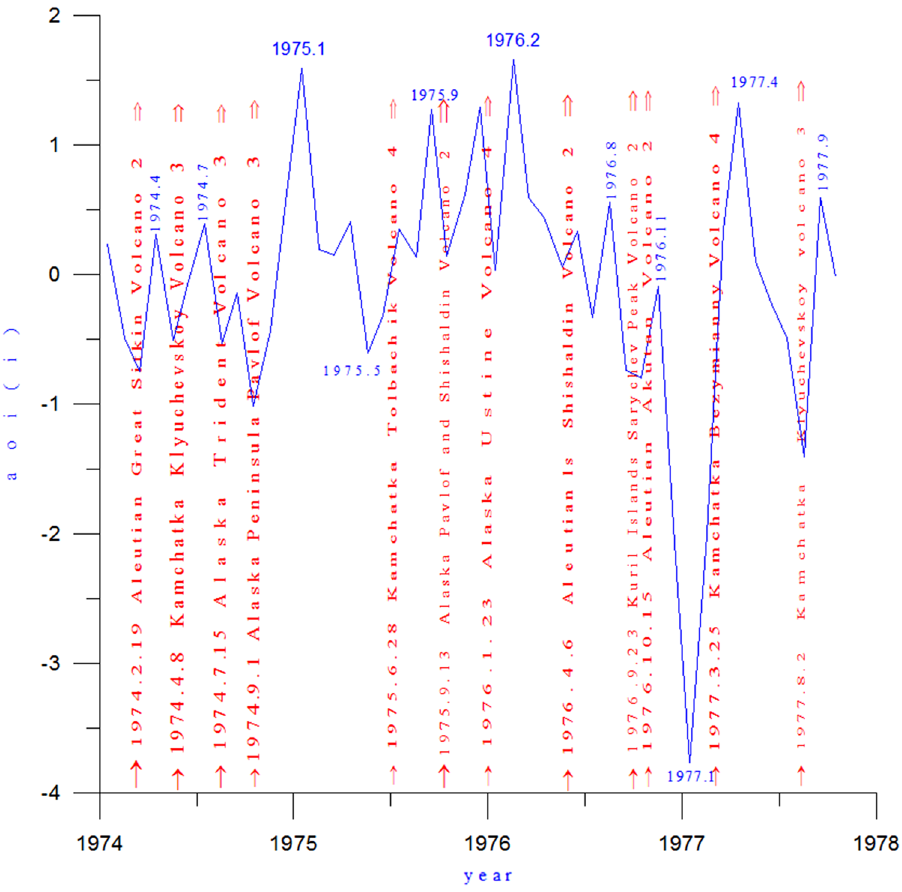
Figure 8. AOI (blue line) and volcanic activity (red arrows) from 1974 to